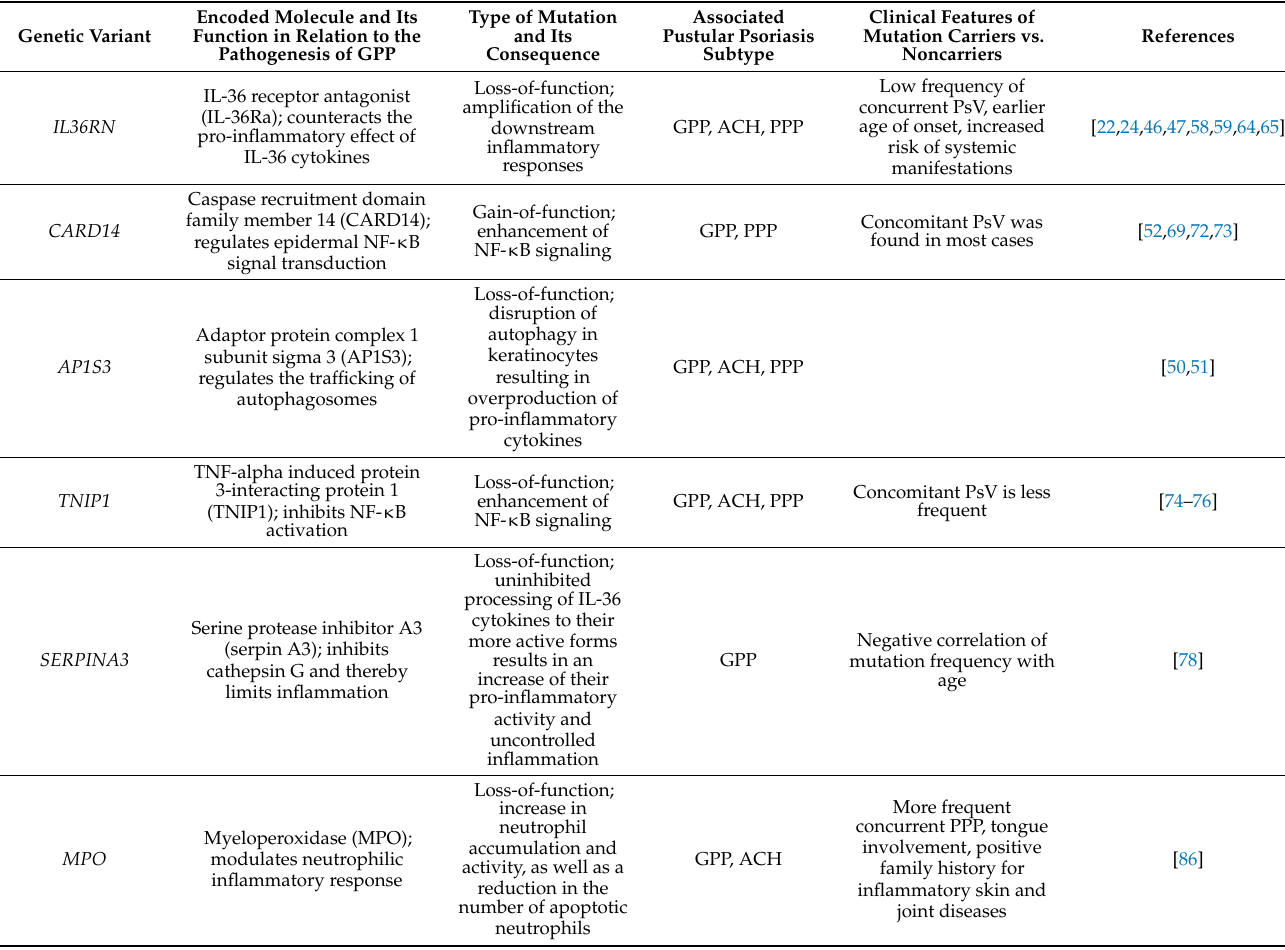
Table 1. Summary of mutations associated with generalized pustular psoriasis. (ACH—acrodermatitis continua Hallopeau, GPP — generalized pustular psoriasis, IL-36 — interleukin 36, NF- ƙ B — nuclear factor kappa-light-chain-en- hancer of activated B cells, PPP — palmoplantar pustulosis, PsV — psoriasis vulgaris).